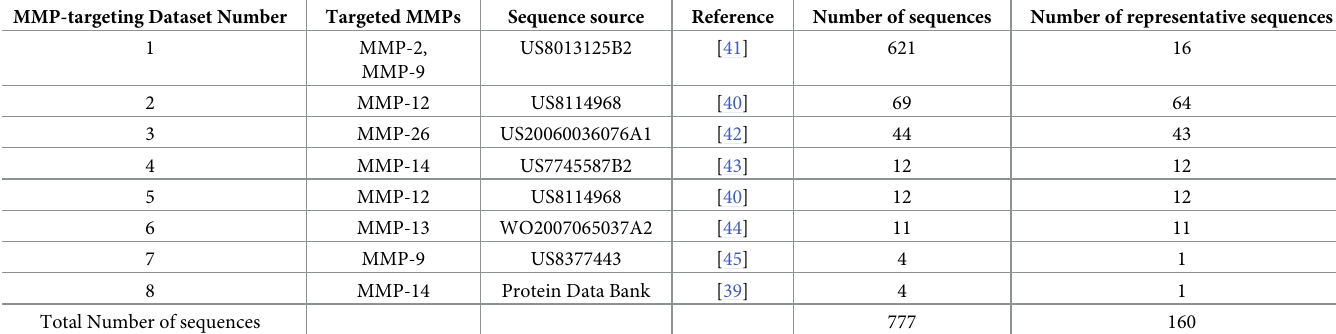
Table 2. The MMP-targeting antibody set comprises 8